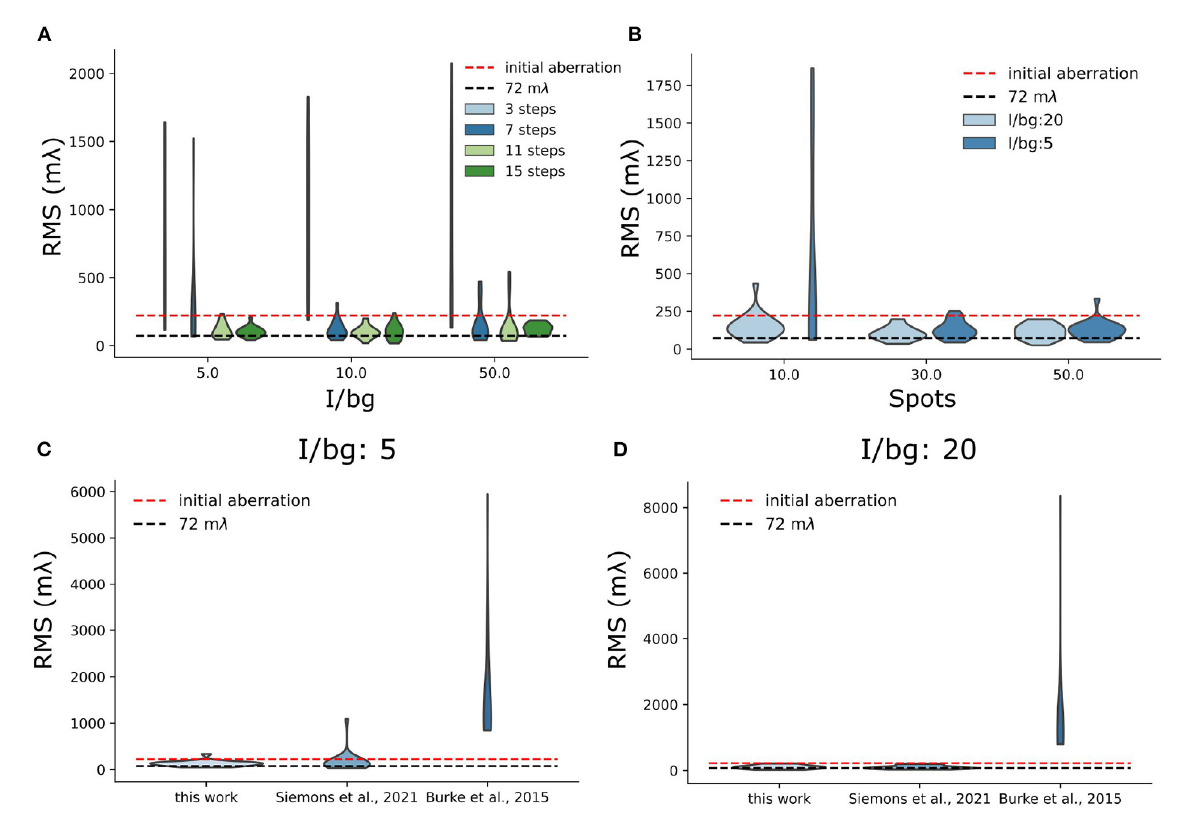
FIGURE9 Simulation test of sensorless AO algorithm. (A) Stability test of sensorless regarding the number of measurement step per frame. (B) Stability test of sensorless regarding the number of blinking single-molecules per frame. For this test, we used 11 measurement steps. (C,D) Benchmark different sensorless AO correction metric functions under different I/bg ratio (I/bg:5 and I/bg: